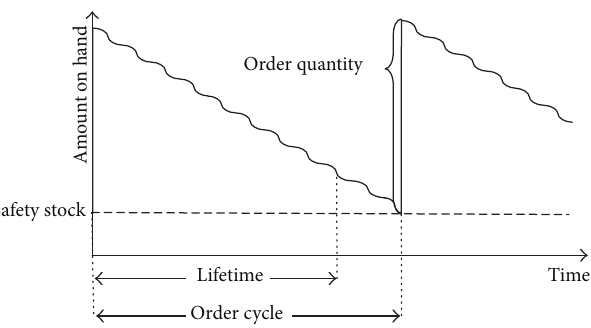
Figure 1: Inventory cycle and lifetime.